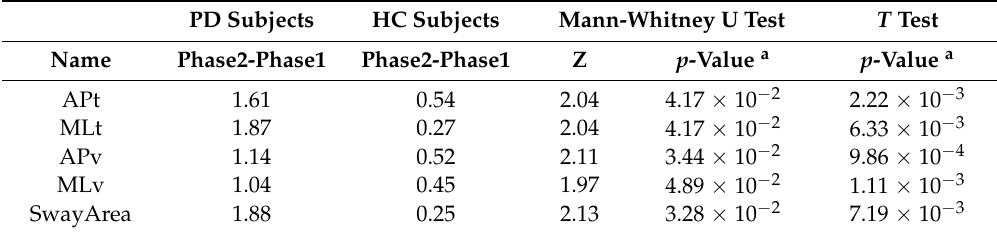
Table 9. Average differences of CoM parameters between Phase1 and Phase2 of the Po task for HC and PD subjects.